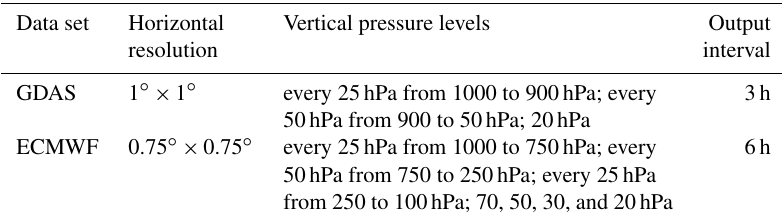
Table 2. Description of GDAS and ECMWF meteorological